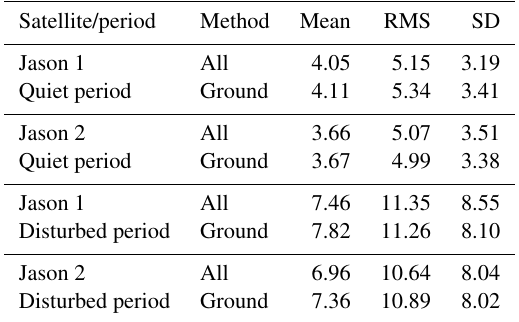
Table 3. Mean, RMS, and SD of the absolute Jason